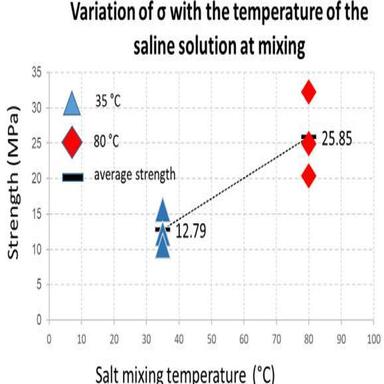
Variation of compressive strength with the temperature of the saline solution.